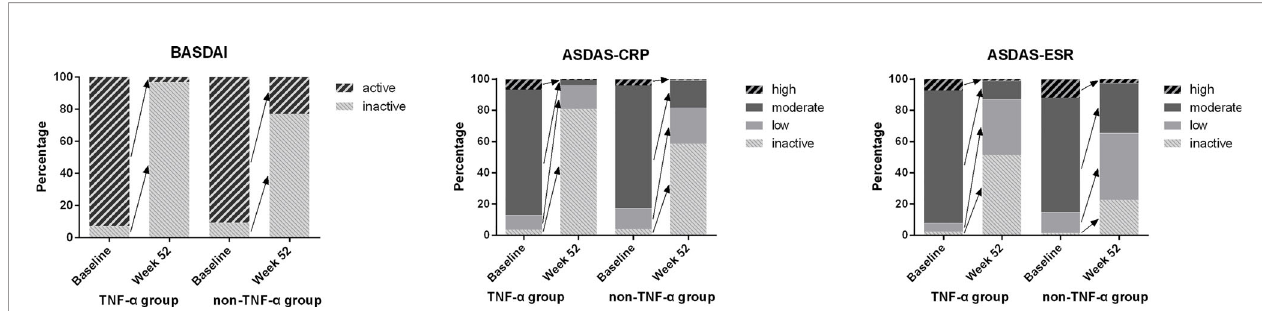
FIGURE 2 | Distribution of disease activity between baseline and week 52 in both groups. Notes. Inactive disease: ASDAS-CRP ≤ 1.3, ASDAS-ESR ≤ 1.3, or BASDAI ≤ 4. Low disease activity: 1.3 < ASDAS-CRP/ASDAS-ESR ≤ 2.1. Moderate disease activity: 2.1 < ASDAS-CRP/ASDAS-ESR ≤ 3.5. High disease activity: ASDAS-CRP/ASDAS-ESR > 3.5. Active disease: BASDAI > 4. ASDAS, Ankylosing Spondylitis Disease Activity Score; CRP, C-reactive protein; ESR, erythrocyte sedimentation rate; BASDAI, Bath Ankylosing Spondylitis Disease Activity